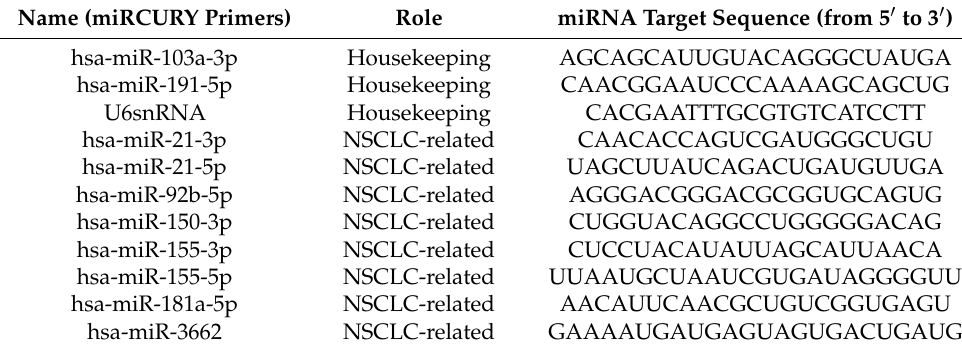
Table 2. miRCURY LNA miRNA PCR assay primers for RT-qPCR miRNA